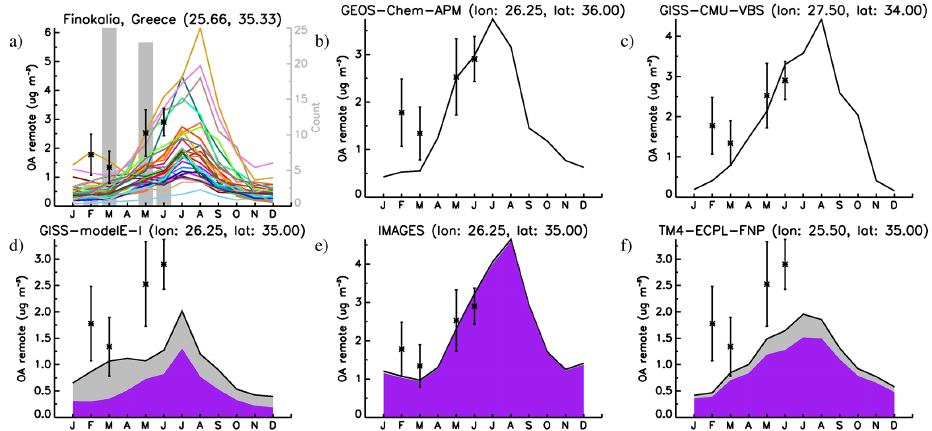
Figure 19. Same as in Fig. 18, for OA (years 2008 and 2009). The chemical composition in (b–f) (where available) is presented as defined by the AMS: HOA (grey) and OOA